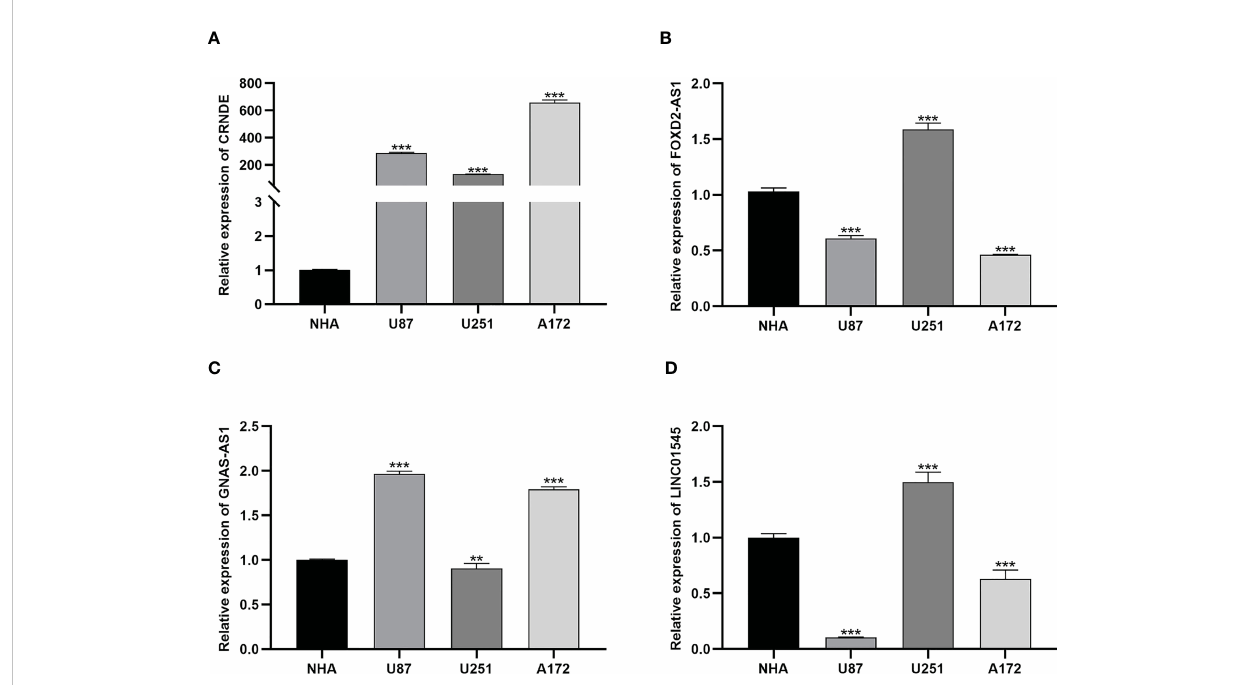
FIGURE 5 The results of qRT-PCR. (A) The expression of CRNDE in NHA, U87, U251 and A172 cell lines. **, and *** represent p< 0.05, p< 0.01, and p< 0.001, respectively, statistically analyzed by ANOVA. (B – D) The expression of FOXD2-AS1, GNAS-AS1 and LINC01545 in NHA, U87, U251 and A172 cell lines,